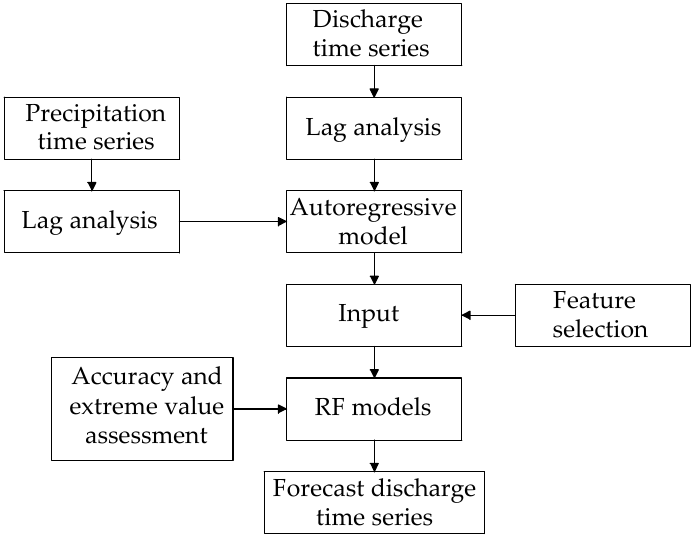
Figure 3. Scheme of the step-wise methodology for developing precipitation-runoff forecasting